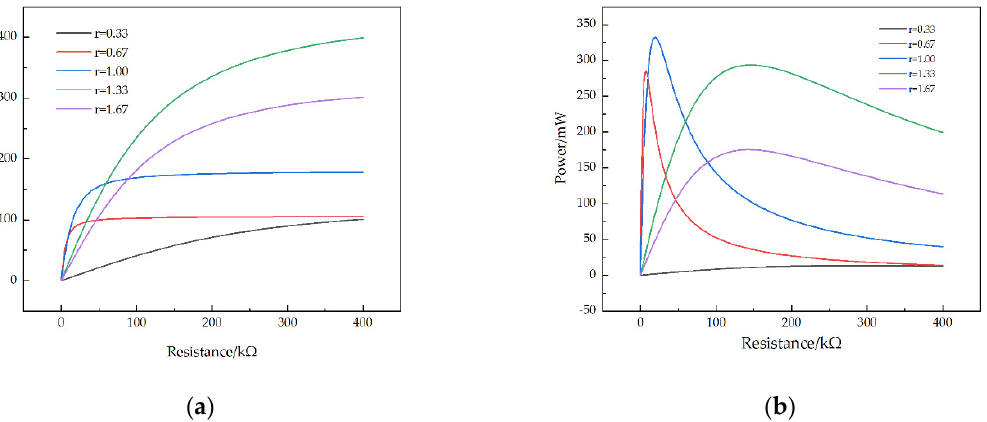
Figure 10. Output performance-resistance curves of the STTM-PEH with different T-shaped trape- zoidal cantilever beam substrate thicknesses. ( a ) Output voltage-resistance curves. ( b ) Output power–resistance coefficient curves.